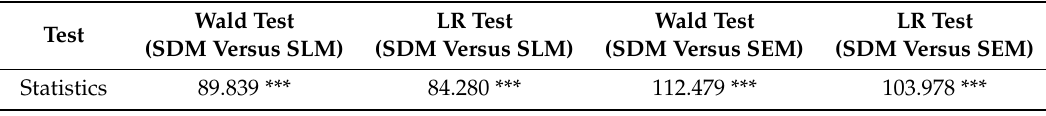
Table 5. Results of Wald and LR tests for the spatial Durbin model under the spatial and time fixed effects. Wald Test Test